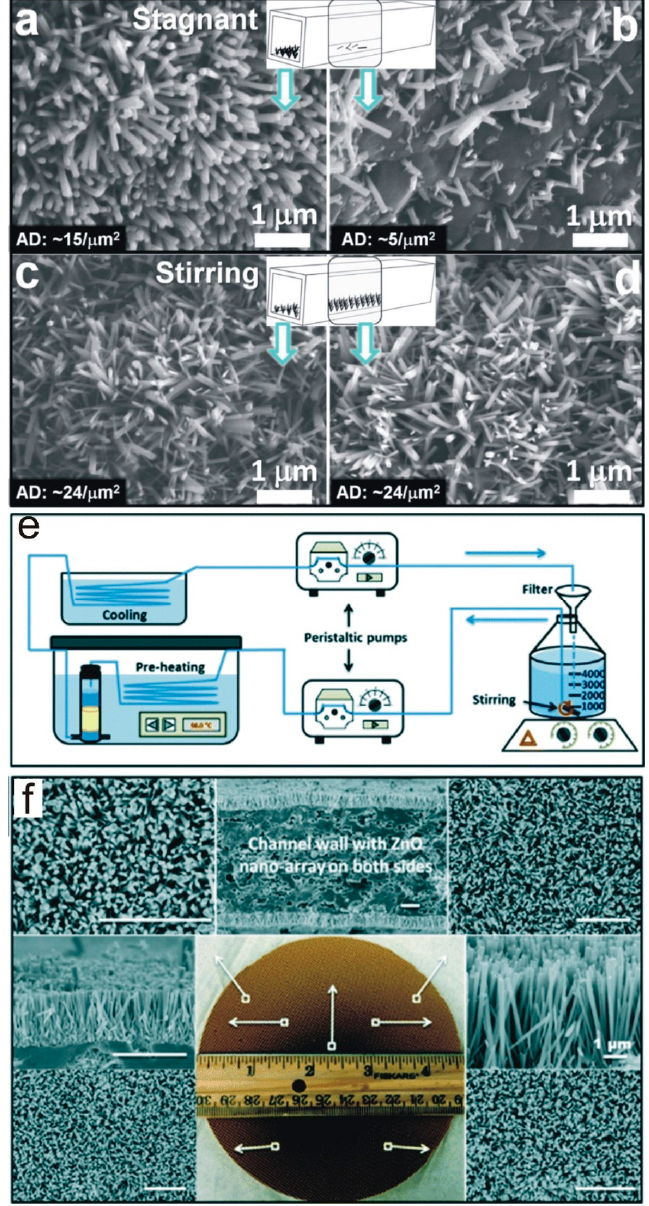
Figure 5. Mechanical agitation ‐ assisted hydrothermal growth of ZnO nano ‐ arrays. ( a – d ) SEM images of the as ‐ grown nano ‐ arrays at the end and center regions of cordierite channels after synthesis with and without mechanical agitation; ( e ) Experimental setup of the continuous flow synthesis for scalable integration of ZnO nanorod array on 3D honeycomb cordierite; ( f ) Uniformly distributed ZnO nanorod array on a monolithic substrate fabricated by continuous flow synthesis. Reprinted with permission from [12], Copyright RSC, 2016. Reprinted with permission from [14], Copyright ACS, 2013.